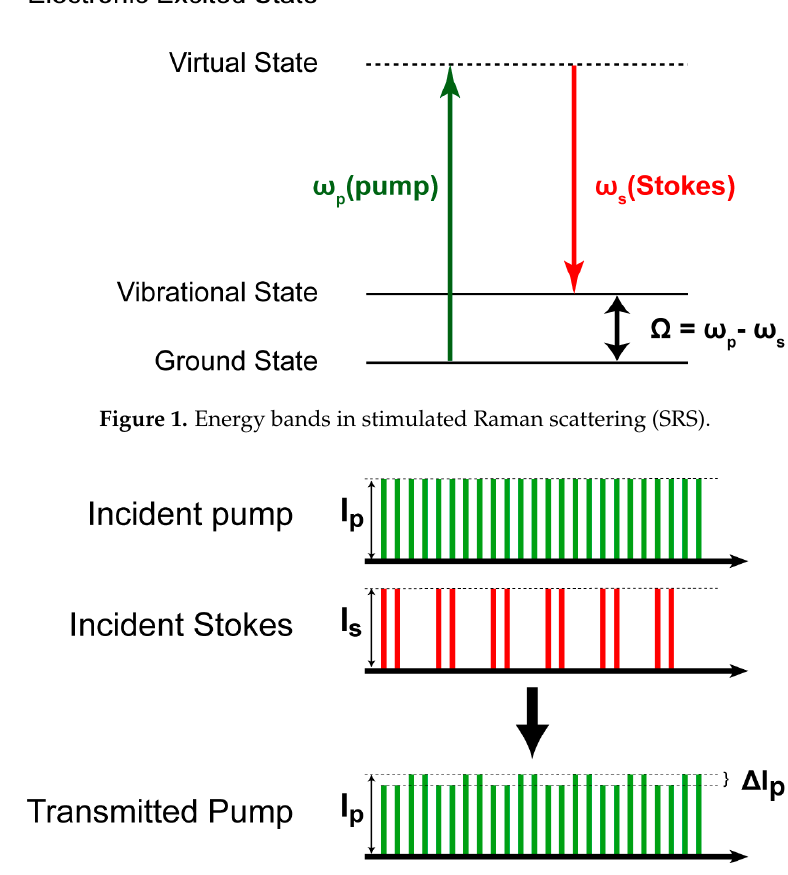
Figure 2. High-speed modulation for small SRS signal.